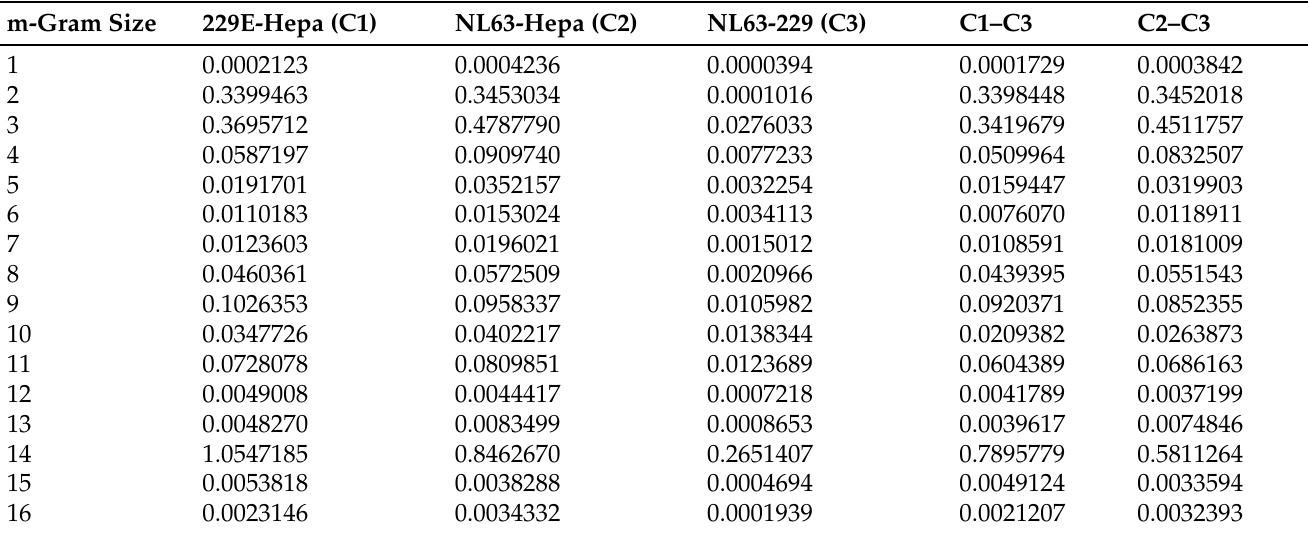
Table 2. Distance scores (229E-Hepa ( C1 ), NL63-Hepa ( C2 ), and NL63-229 ( C3 )) of the Doc2Vec vectors of the three viruses and the differences of these distances ( C1–C3 and C2–C3 ) using different m-gram sizes.